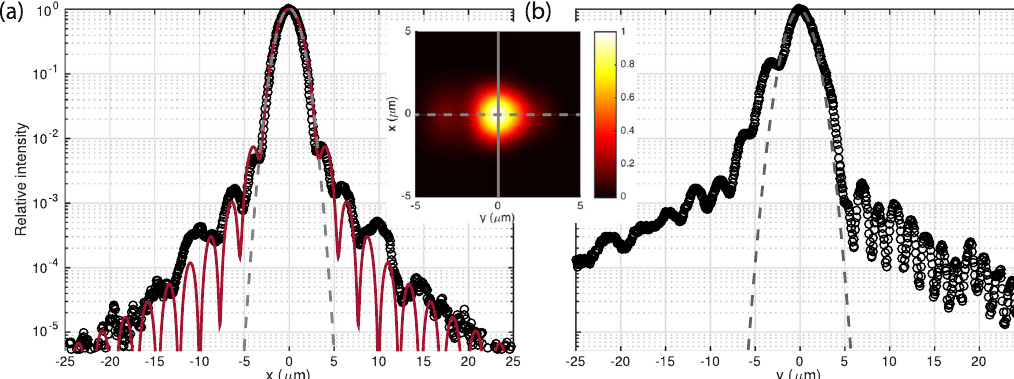
Figure 4. Intensity profiles along x ( a ) and y ( b ) imaged at a height of z = 50 μ m. The inset shows the recorded intensity profile at this height, with the solid and dotted lines corresponding to the horizontal axes for ( a ) and ( b ) respectively. In each case the measured data points (black circles) are taken from a set of images with exposure times varying by a factor of 400 to allow sufficient dynamic range. Ideal Gaussian fits with 1/ e 2 half-widths of 2.0 μ m ( a ) and 2.3 μ m ( b ) are shown in the dotted gray lines, as well as in ( a ) the result of a 1D diffraction integral calculation (solid red line) for the intensity profile resulting from the cosine-shape field profile expected along x in the grating